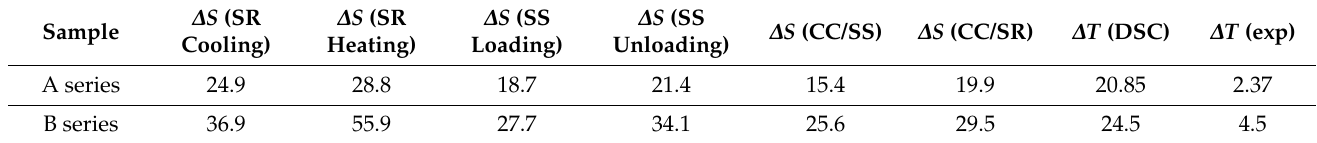
Table 2. Peak values and maximum values for enthalpy change ∆ S and ∆ T for the A and B sample series. The ∆ S values are expressed in J/kgK. CC/SS and CC/SR are the entropy change values obtained using the Clausius–Clapeyron coefficient obtained from stress–strain (SS) curves or strain recovery (SR) curves; the ∆ T values are expressed in